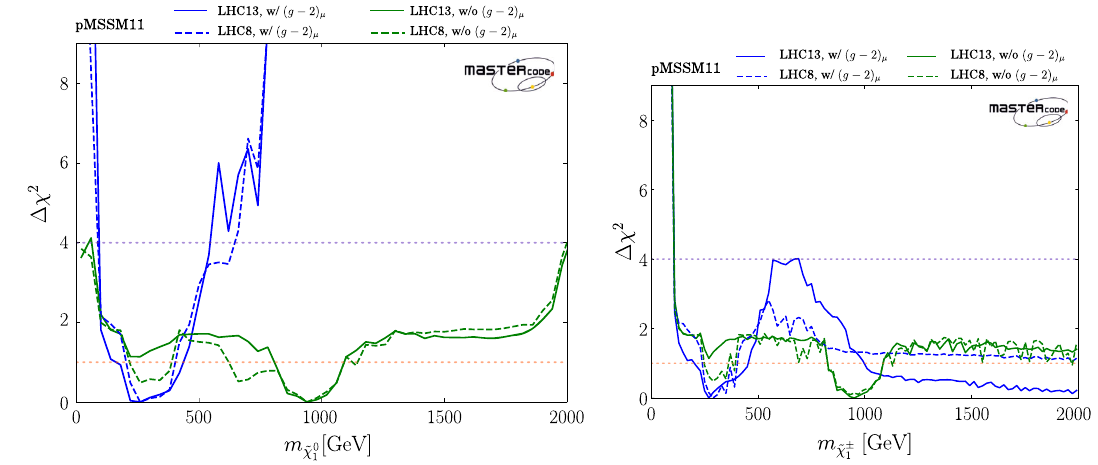
Fig. 11 Left panel: One-dimensional profile likelihood functions for the ˜ χ 0 (green) and with (solid) and without (dashed) applying the constraints from LHC Run II. Right panel: Similarly for the ˜ χ ±